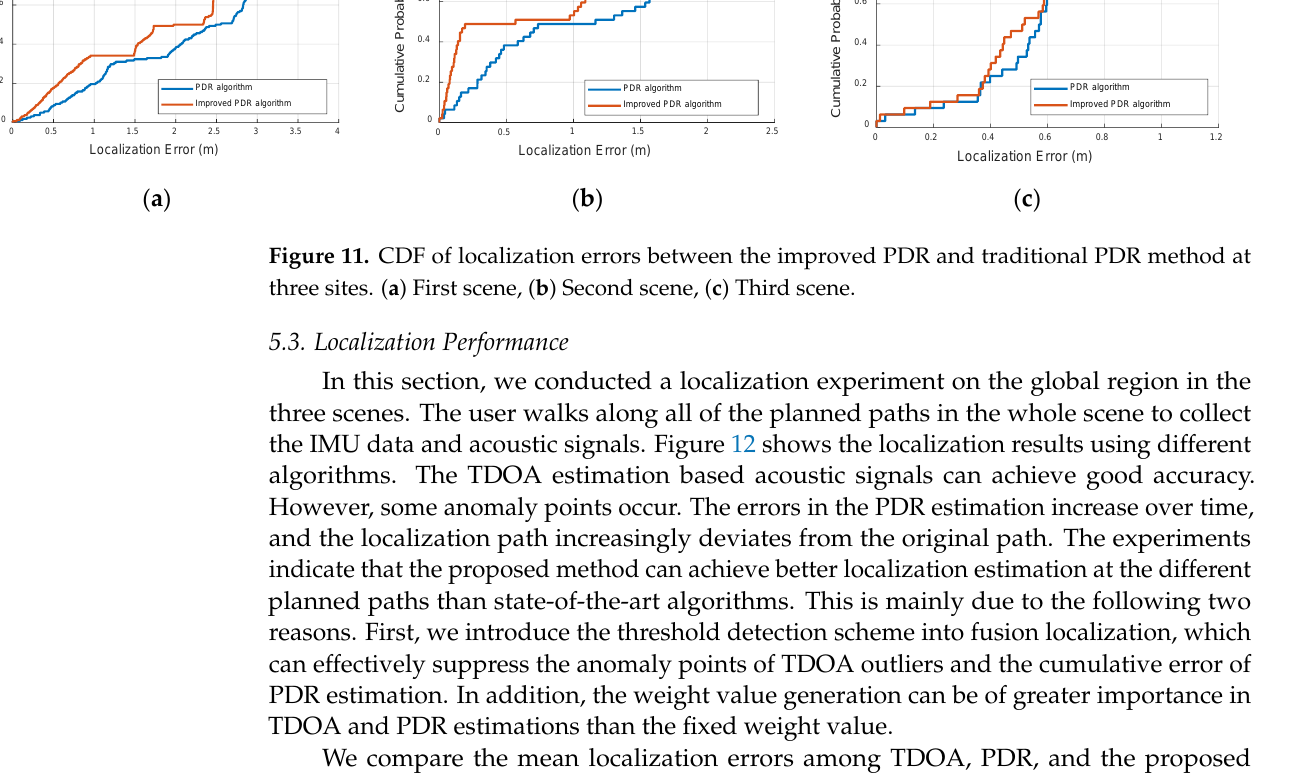
PDR algorithm Improved